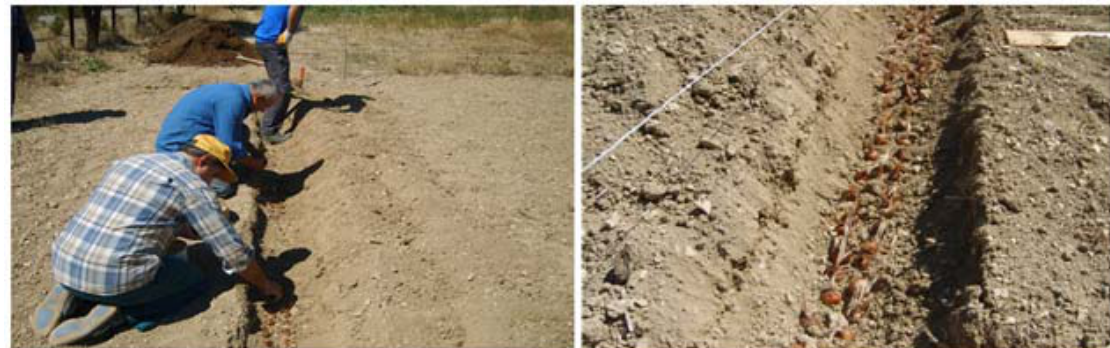
Figure 4. Cultivation of saffron